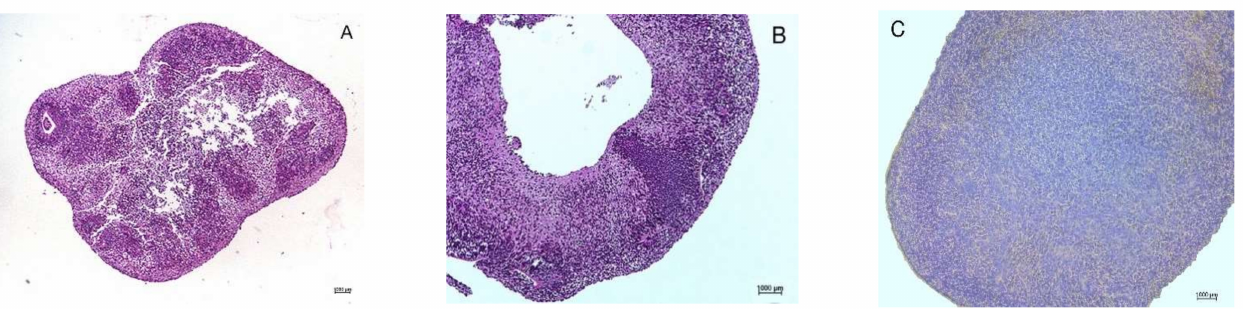
Figure 3. The central zone of cerebral organoids. ( A ) Organoid with a necrotic central zone. ( B ) The central zone degraded completely and disintegrated, forming a cavity. ( C ) Organoid with an intact central zone. Hematoxylin-eosin staining of cryosections fixed in 4% buffered PFA (10 × magnification). Own